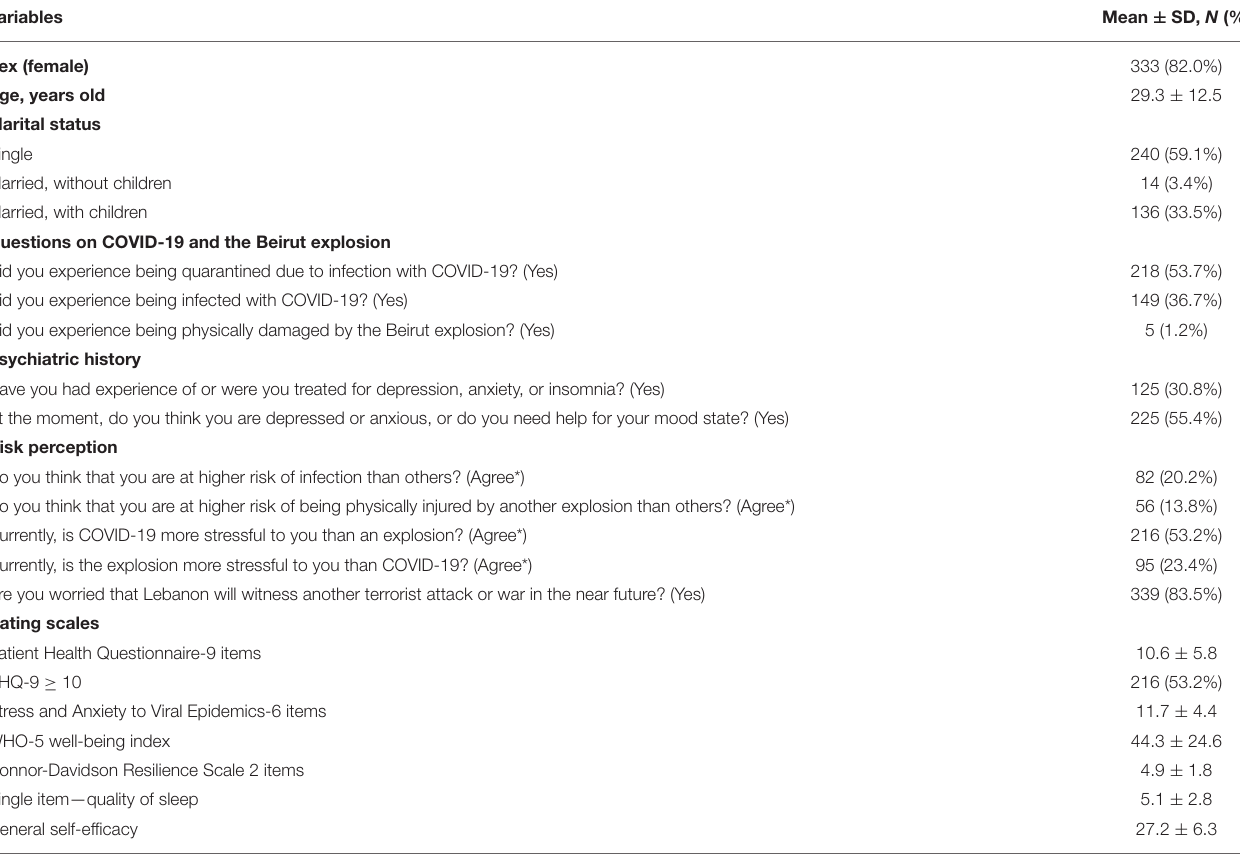
TABLE 1 | Demographic characteristics of participants ( N =